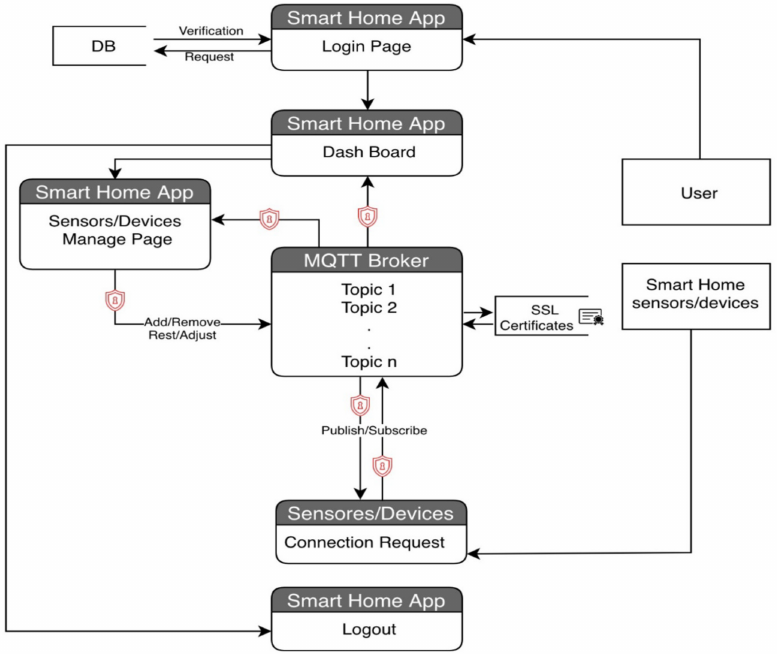
Figure 3. The functional requirement for smart home MQTT